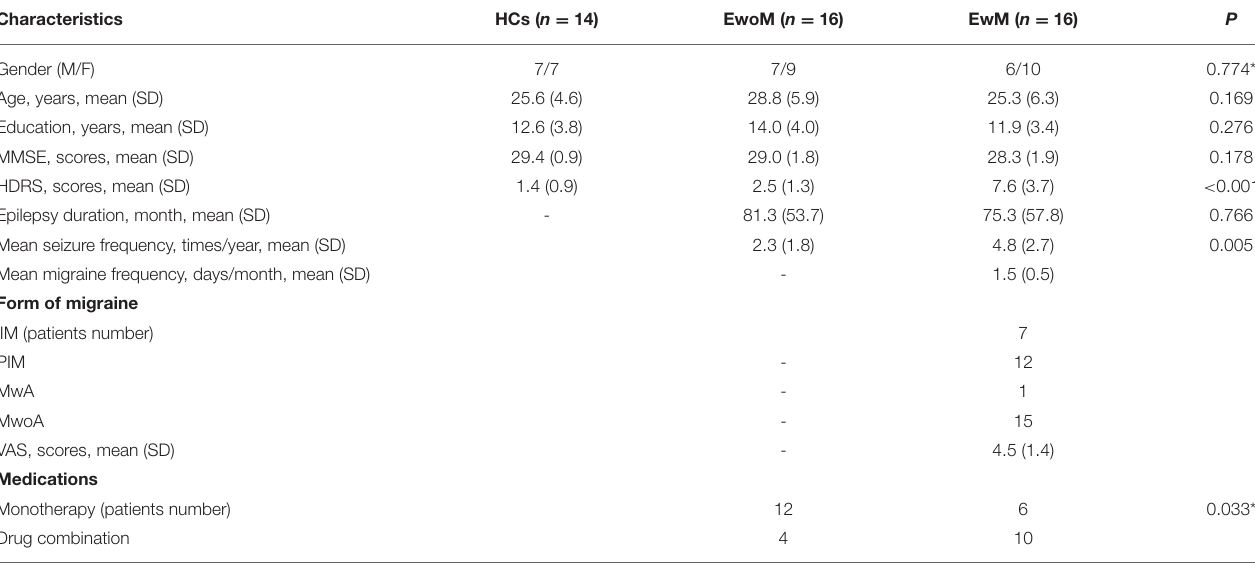
TABLE 1 | Demographic and clinical characteristics of the